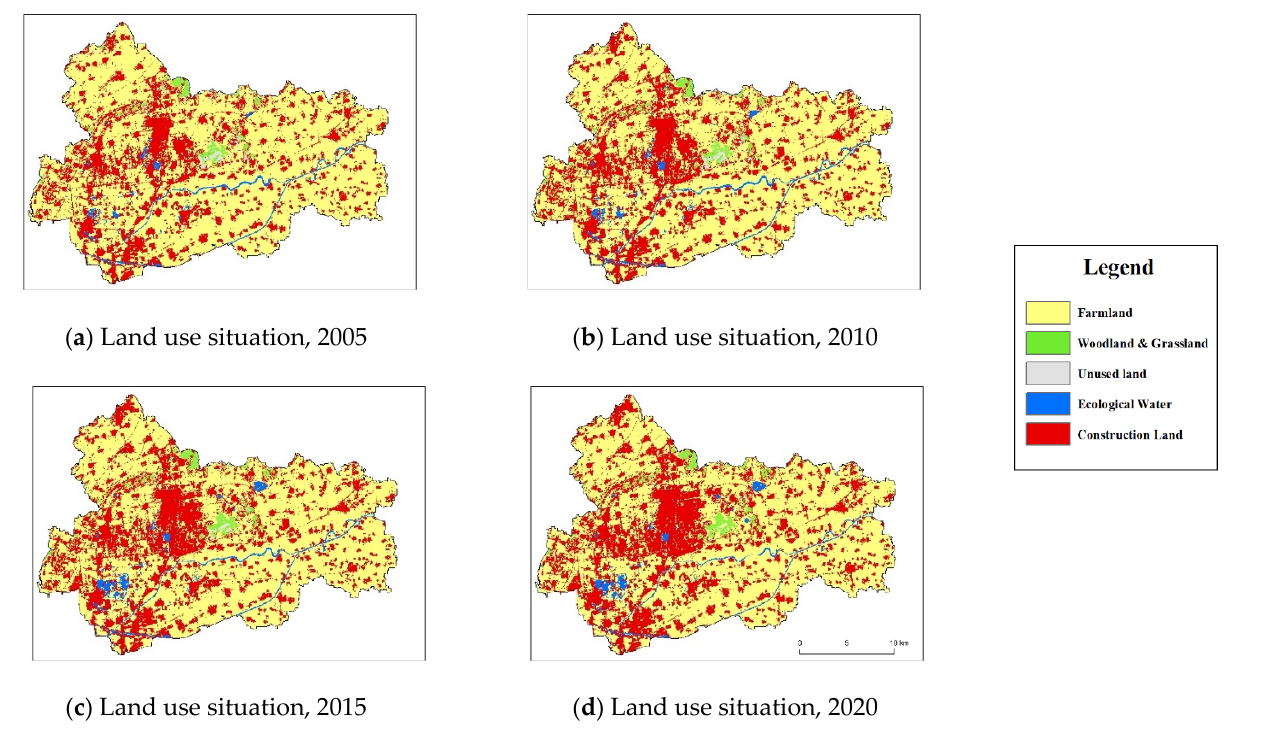
Figure 3. Land use in the study area from 2005 to 2020.